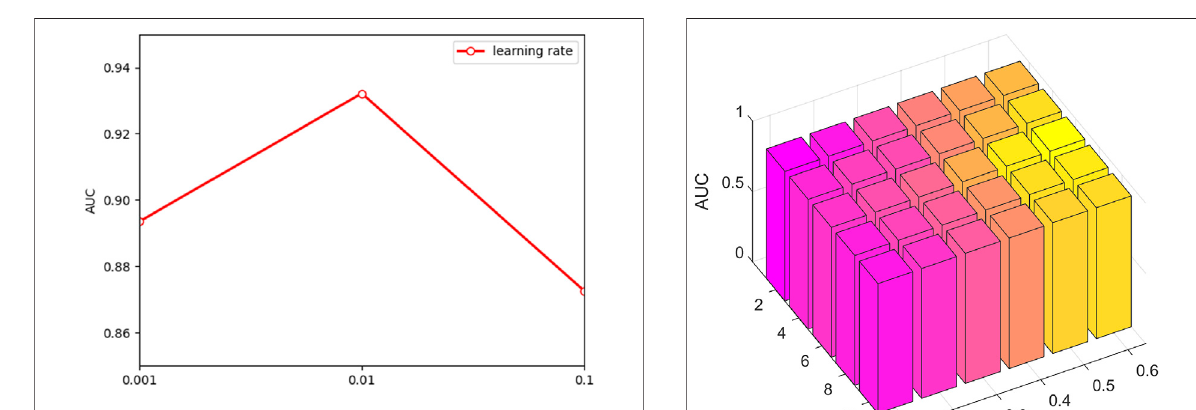
FIGURE 2 | Outcome of comparing various learning rates.